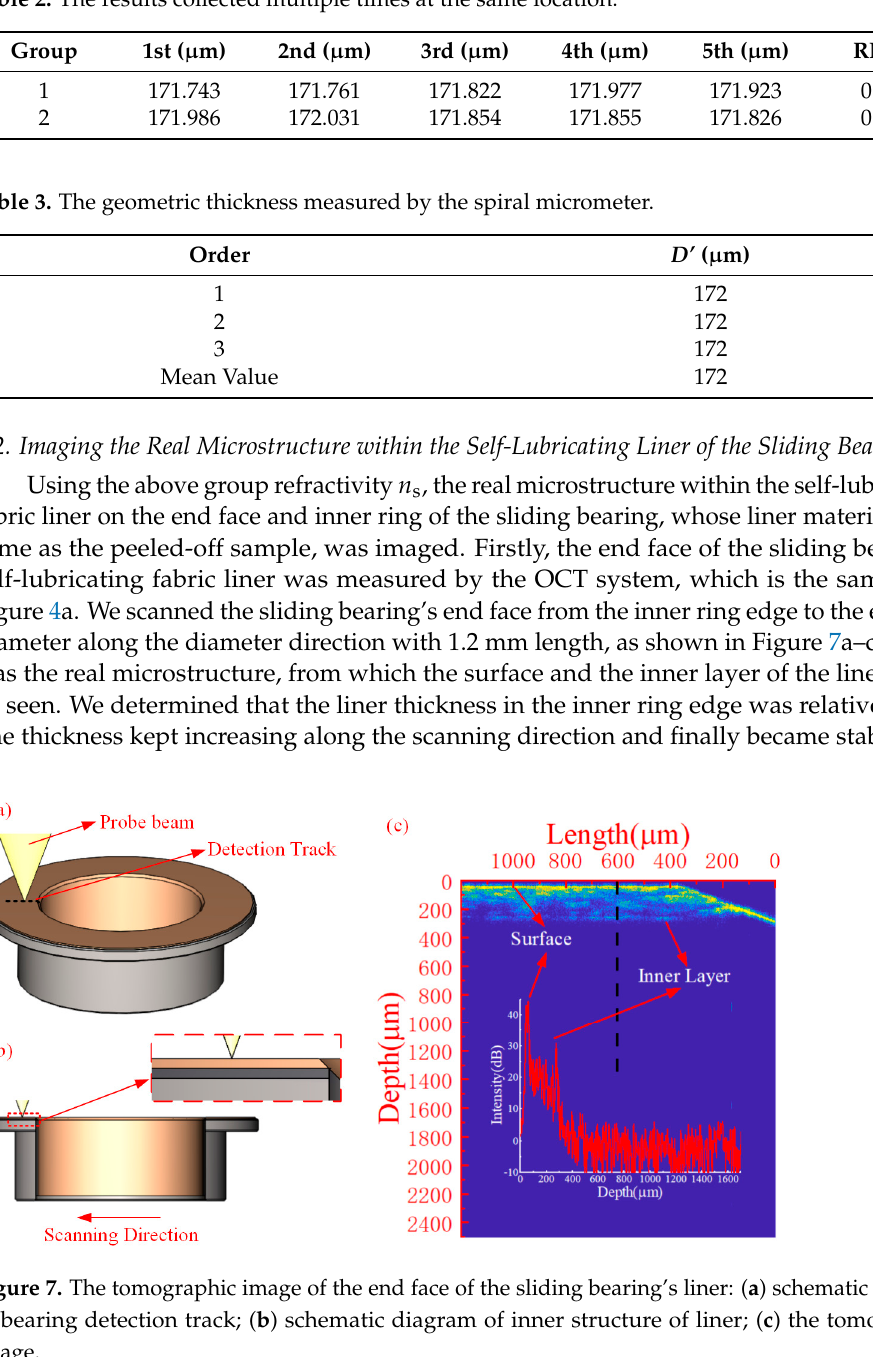
Table 2. The results collected multiple times at the same location.